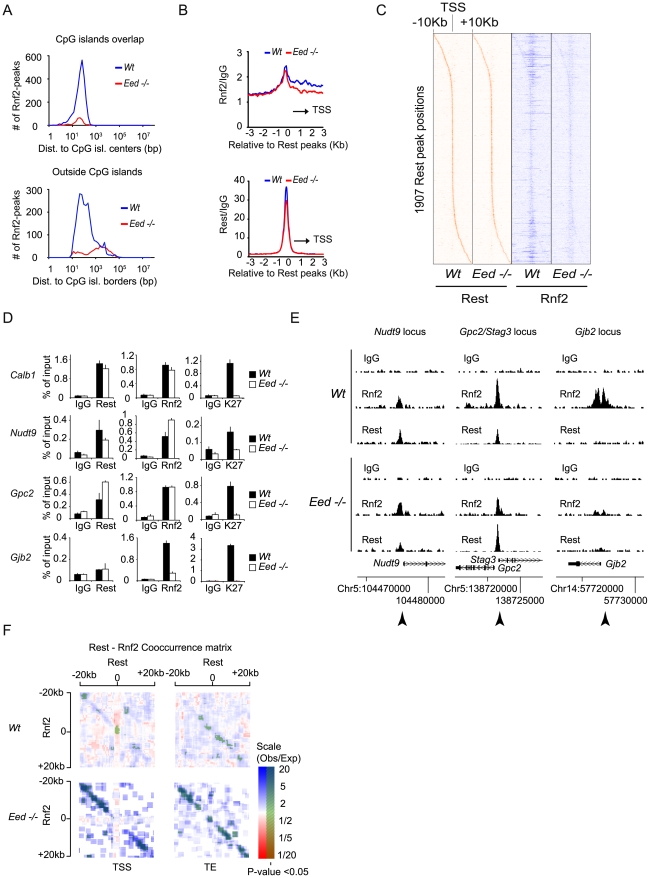
The recruitment of PRC1 at a number of Rest binding sites is independent of PRC2 activity in mES cells.(A) Histograms showing the number of Rnf2 peaks in Wt and Eed−/− mES cells at positions relative to CpG islands. Upper panel: Rnf2 peaks that overlap with CpG-islands relative to the distance between the center of the peak and the center of the CpG-island. Lower panel: Rnf2 peaks, not overlapping with annotated CpG-islands, plotted relative to the distance between the borders of the Rnf2 peak and the border of the CpG-island. (B) Average ChIP-seq reads in E14 Wt and Eed−/− for Rnf2 (upper panel) and Rest (lower panel) within 3 Kb of the 5,097 Rest peaks identified in E14 Wt mES cells (Table S5). Read counts were normalized to the IgG control. The black arrow indicates the direction of the nearest TSS. (C) Heat-maps of Rest and Rnf2 in Wt and Eed−/− mES cells at 1,907 Rest peaks within 10 Kb of a TSS. (D) Direct ChIP in E14 Wt and Eed−/− mES cells for Calb1, Nudt9, Gpc2/Stag3 and Gjb2 (positions of primers used are indicated by arrow heads in E). Error bars represent standard deviations calculated from triplicate qPCR reactions. (E) ChIP-seq profiles for the Nudt9, Gpc2/Stag3 and Gjb2 loci using antibodies for Rnf2, Rest and control IgG. (F) Co-occurrence matrix of Rest and Rnf2 peaks from Wt and Eed−/− mES cells. The maps are based on scans, with a 2,500 bp window, along different positions near the transcription start site (TSS) or transcription end points (TE) annotated in the mouse genome (Mouse genome: mm9). For each scan the number of observed peaks were calculated and normalized to the number of expected peaks based on the frequency of Rest and Rnf2 peaks in that particular position, relative to the TSS or TE. Scans with a higher or lower frequency than expected from random localization, were colored blue or red, respectively. Scans with a P-value below 0.05 (Bonferroni corrected for multiple sampling), are overlaid with transparent green color.